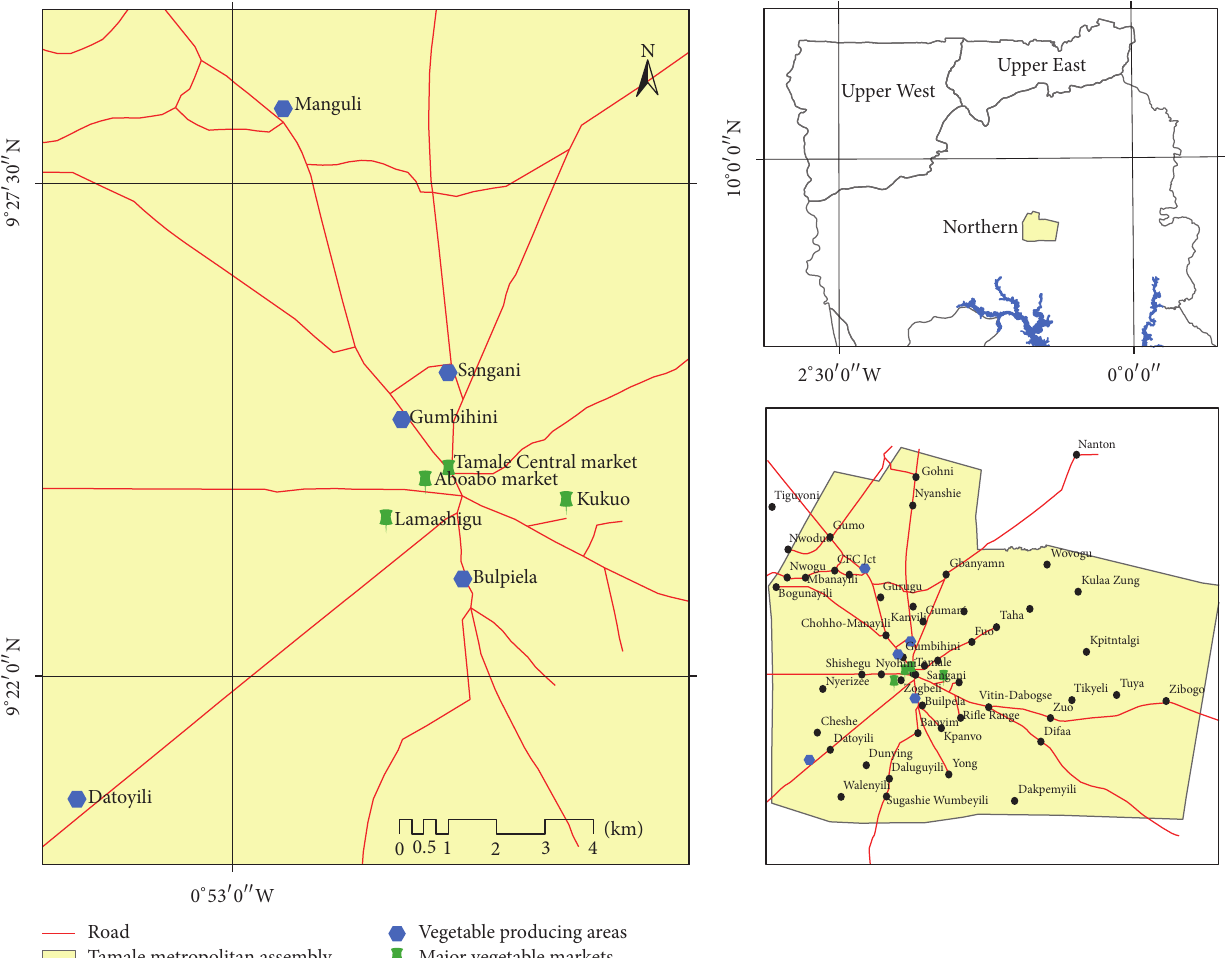
Figure 2: Map of Tamale metropolitan area showing major vegetable producing areas and